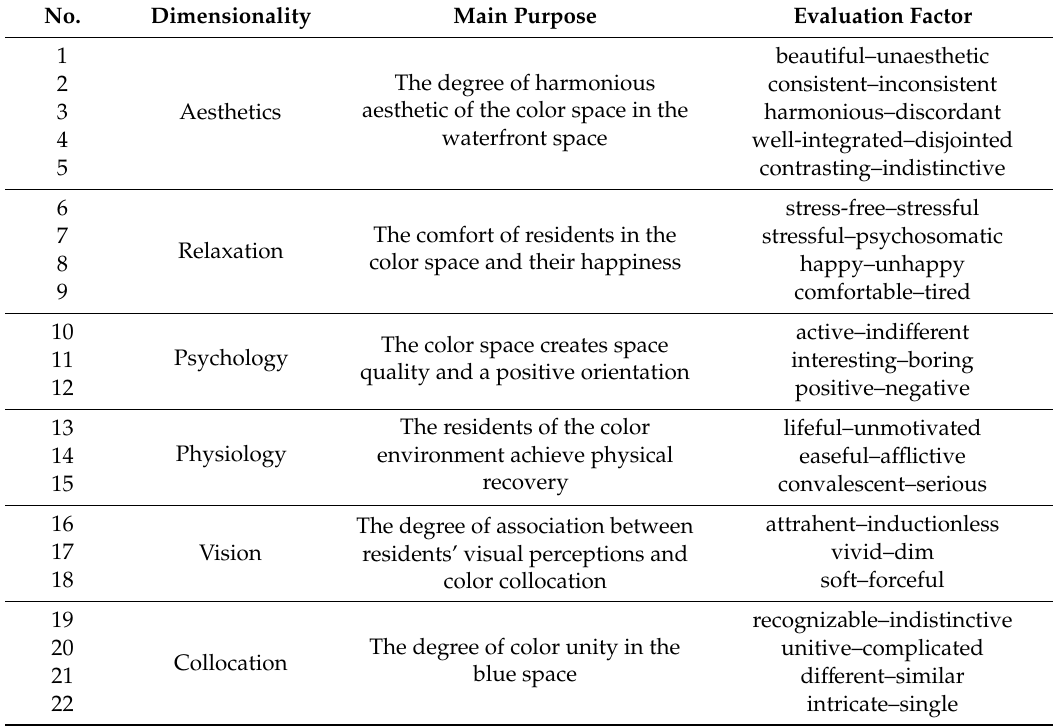
Table 2. Color space perceptions and recovery evaluations of waterfront semantic di ff erential (SD) factor.